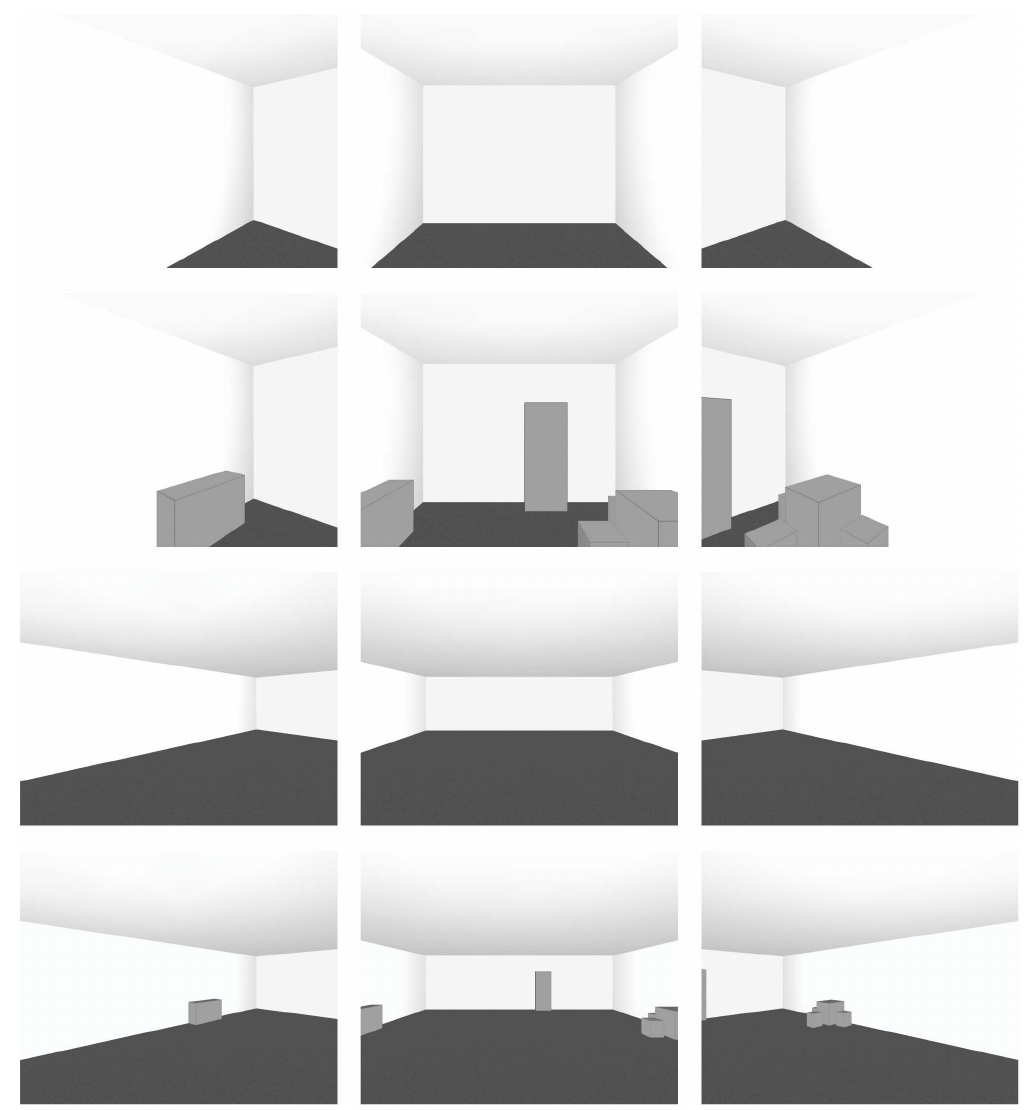
Figure 6. Experiment 2: Two-dimensional screenshots of the smallest (above) and the largest (below) virtual room in the furnished and unfurnished condition, each displayed from the leftmost, the default, and the rightmost vantage point.